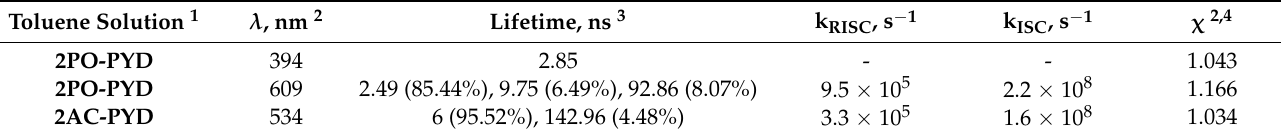
Table 3. Photophysical characteristics of the toluene solutions of 2PO-PYD and 2AC-PYD